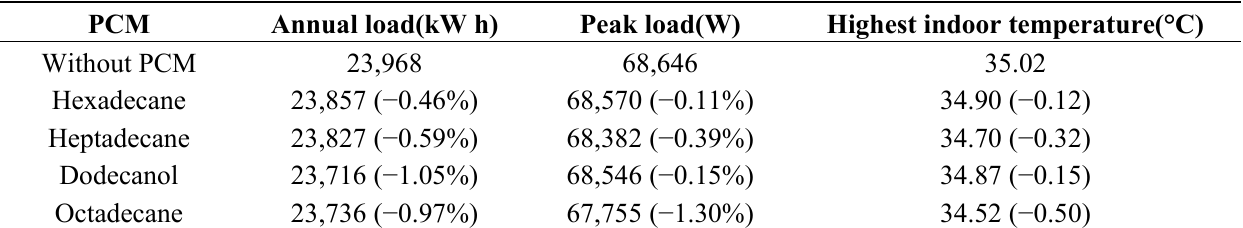
Table 5. Indoor thermal characteristics of the cooling